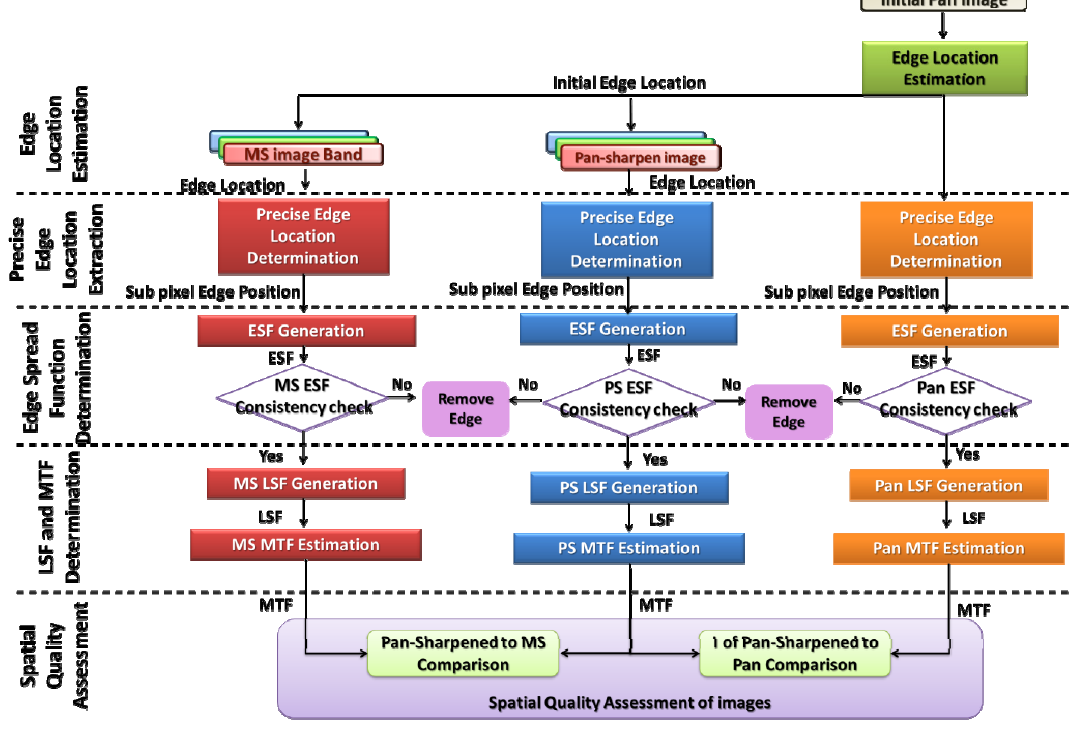
Figure 1. Diagram of the proposed edge-based quality assessment